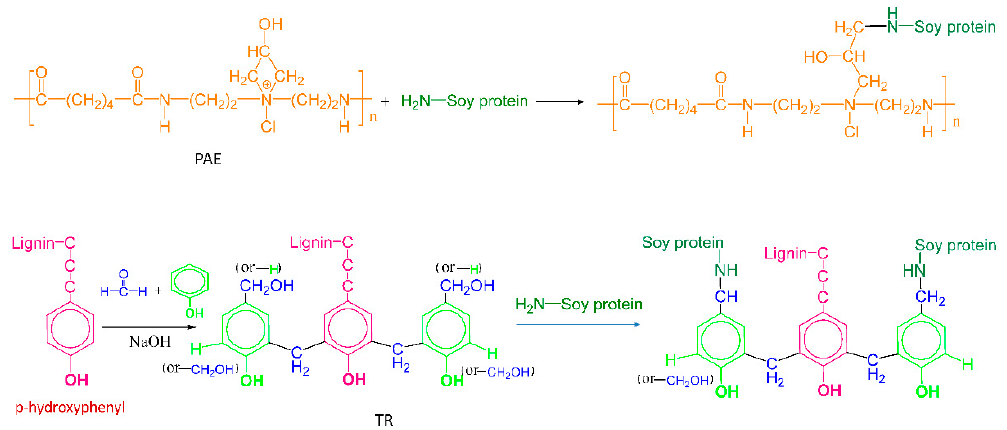
Scheme 1. The reaction of the adhesive components. (PAE: polyamidoamine-epichlorohydrin, TR: Tannin based resin).